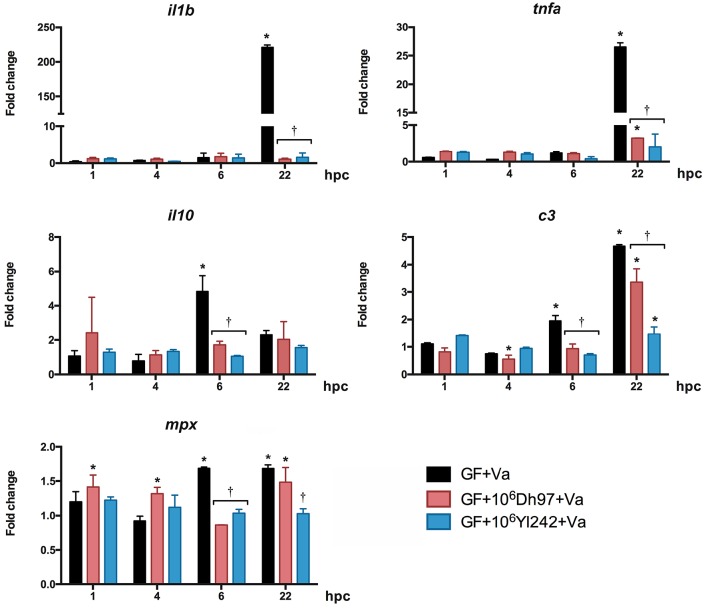
Expression of innate-immune genes analyzed by qPCR in germ-free (GF) larvae challenged with V. anguillarum (Va) at 5 dpf, pre-treated at 4 dpf with 106 CFU/mL of each yeast, relative to non-challenged germ-free larvae. Dh97, Debaryomyces hansenii 97; Yl242, Yarrowia lipolytica 242; il1b, interleukin 1 beta; tnfa, tumor necrosis factor a; c3, complement component 3; mpx, myeloid-specific peroxidase; il10, interleukin 10; hpc, hours post V. anguillarum challenge. Data were normalized to beta actin 1. The results show the mean ± SD of 3 independent experiments with three replicates each. *Indicates statistically significant differences of the experimental groups with non-challenged GF larvae, †Indicates statistically significant differences between the V. anguillarum-challenged GF larvae treated with yeasts (GF + yeast + Va) with V. anguillarum-challenged GF larvae (GF + Va).